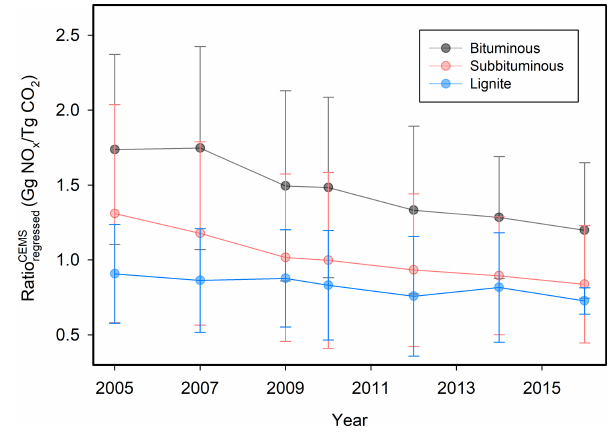
Figure 5. Interannual trends of ratio CEMS ing bituminous, subbituminous, and lignite coal types and without post-combustion NO x control devices in a given year. Error bars show the standard deviations for ratios of E CEMS individual power